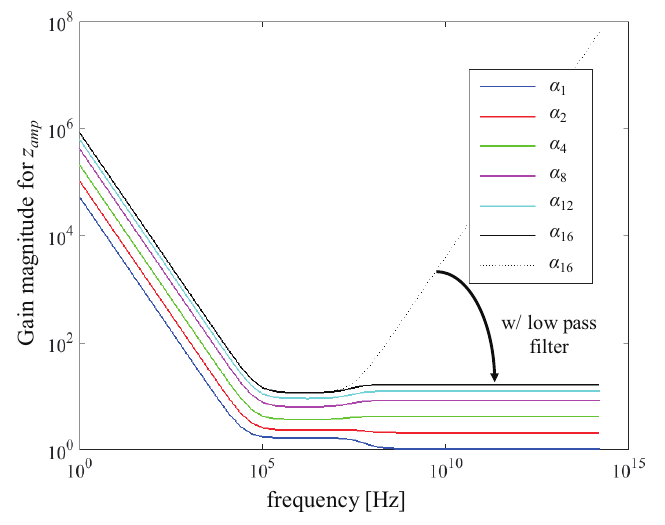
Figure 9. Frequency response for z amp _ j .